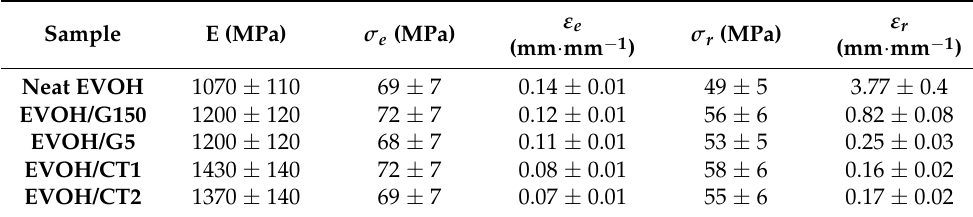
Table 3. Comparison of the mechanical properties of the studied nanocomposites. ( a w = 0.43, T = 25 ◦ C, filler rate = 2